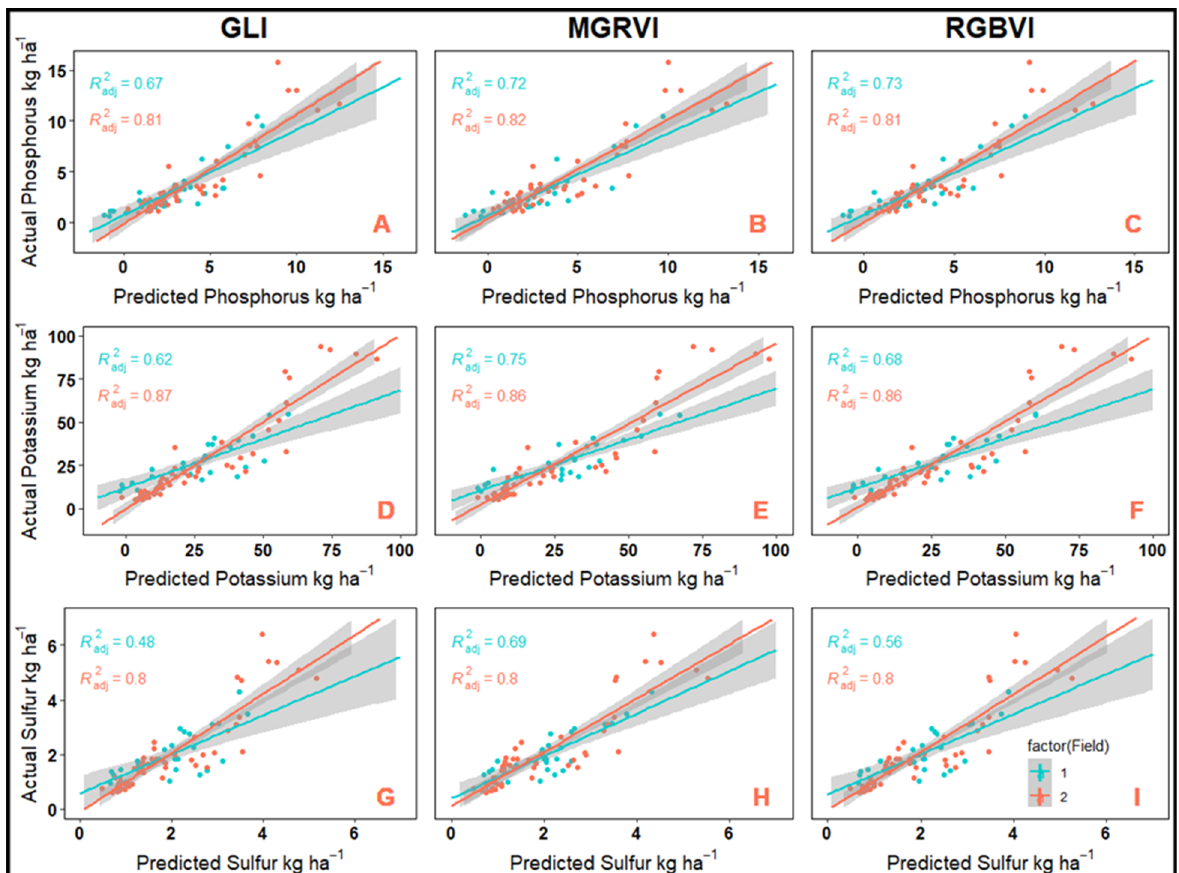
Figure 3. Correlation of in-field measured versus predicted values by field for cereal rye phosphorus, potassium, and sulfur obtained from complex content-based models developed using green leaf index (GLI) ( A —phosphorus, B —potassium, and C —sulfur), modified green red vegetation index ( D —phosphorus, E —potassium, and F —sulfur), and red green blue vegetation index ( G —phosphorus, H —potassium, and I —sulfur).